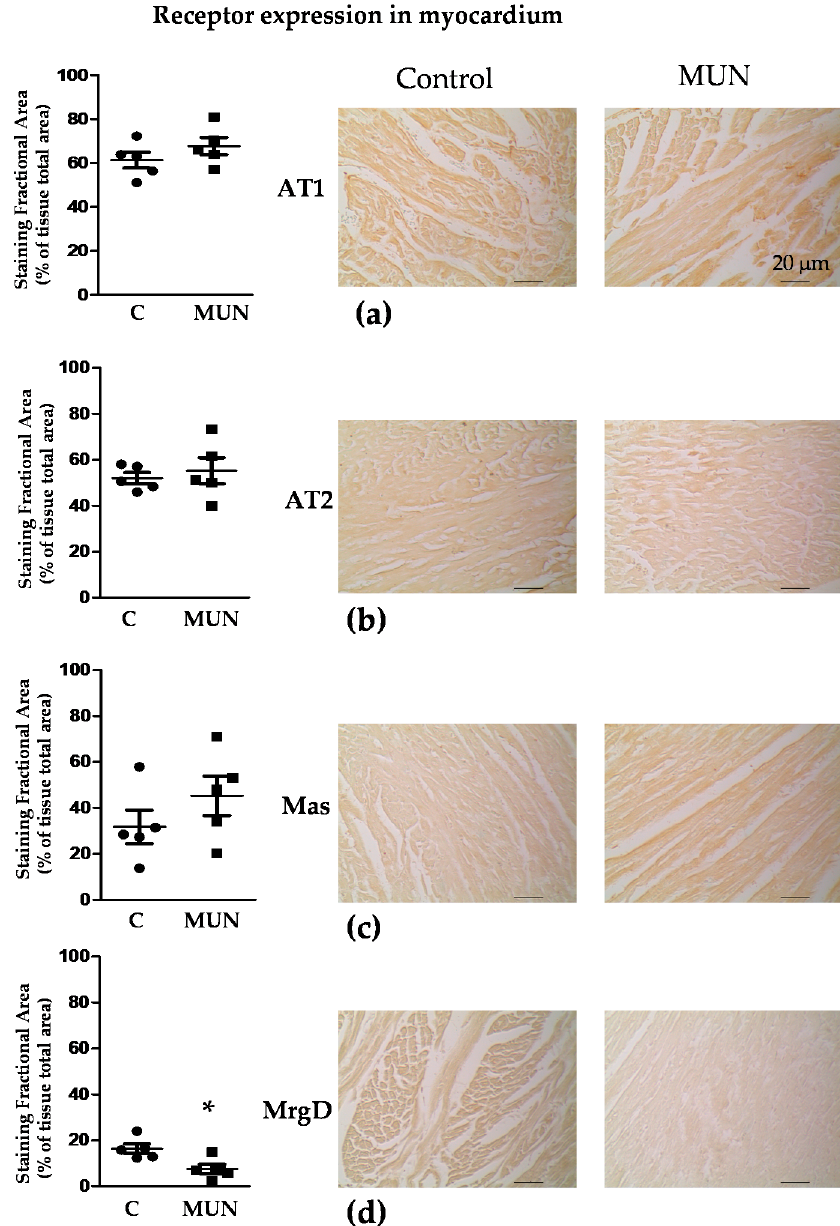
Figure 4. Immunohistochemistry for RAS receptors in the myocardium from 21-day old male offspring from rats exposed to maternal undernutrition during gestation (MUN), and control rats fed ad libitum (C). ( a ) AT1 receptors; ( b ) AT2 receptors; ( c ) Mas receptors; ( d ) MrgD receptors. Heart sections were stained with individual primary antibodies; the resulting immuno-complexes were detected with a biotinylated secondary antibody and amplified by ABC complex, using 3,3 ′ - diaminobenzidine (DAB) as chromogen. Images were obtained with a ×20 objective. Left panels show quantitative analysis of MUN and C myocardium-stained fractional areas (percentage of tissue total area) using SACAIA method. Representative DAB images are shown in right panels (scale bar = 20 µm). Sample size per group: 7 rats from 5 litters. Student’s t test, * p < 0.05 compared to C.